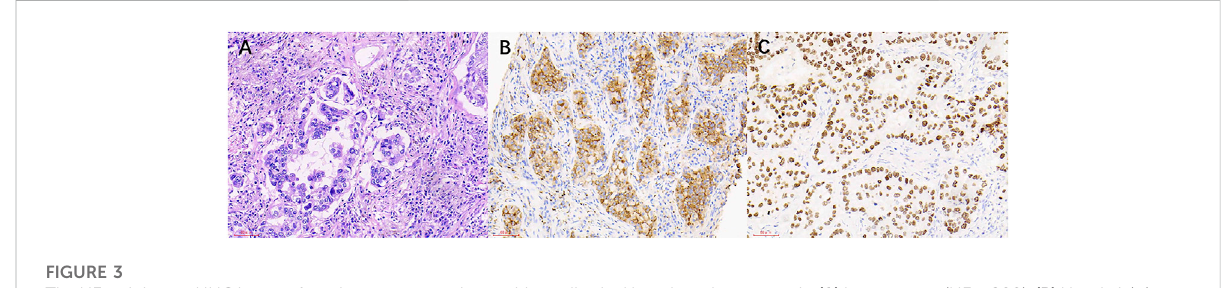
FIGURE 3 The HE stainingand IHC images from lung cancer patients with mediastinal lymph node metastasis. (A) Lungcancer(HE × 200). (B) NapsinA (+) (SP × 200). (C) TTF-1 (+) (SP × 200).